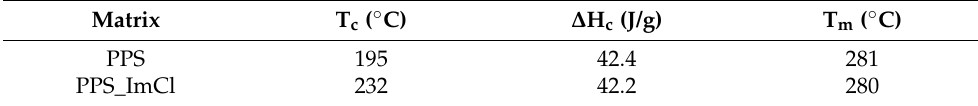
Figure 4. DSC thermograms of neat PPS (black line), PPS_ImCl (orange line and transformation curves. Table 5. Thermal properties of PPS and PPS_ImCl.